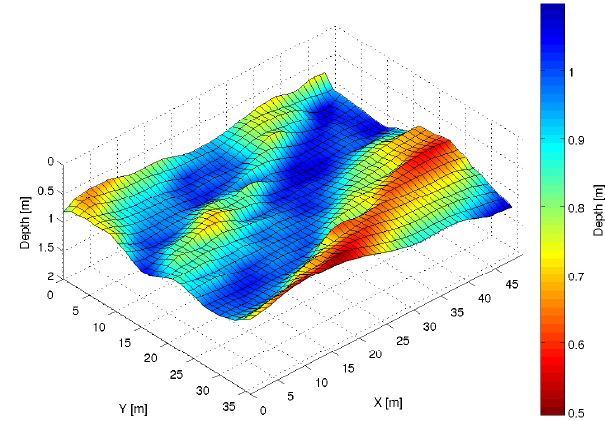
Fig. 6. Three dimensional reflector depth map for the dune-deposit structure using average data from a time series GPR measurements.